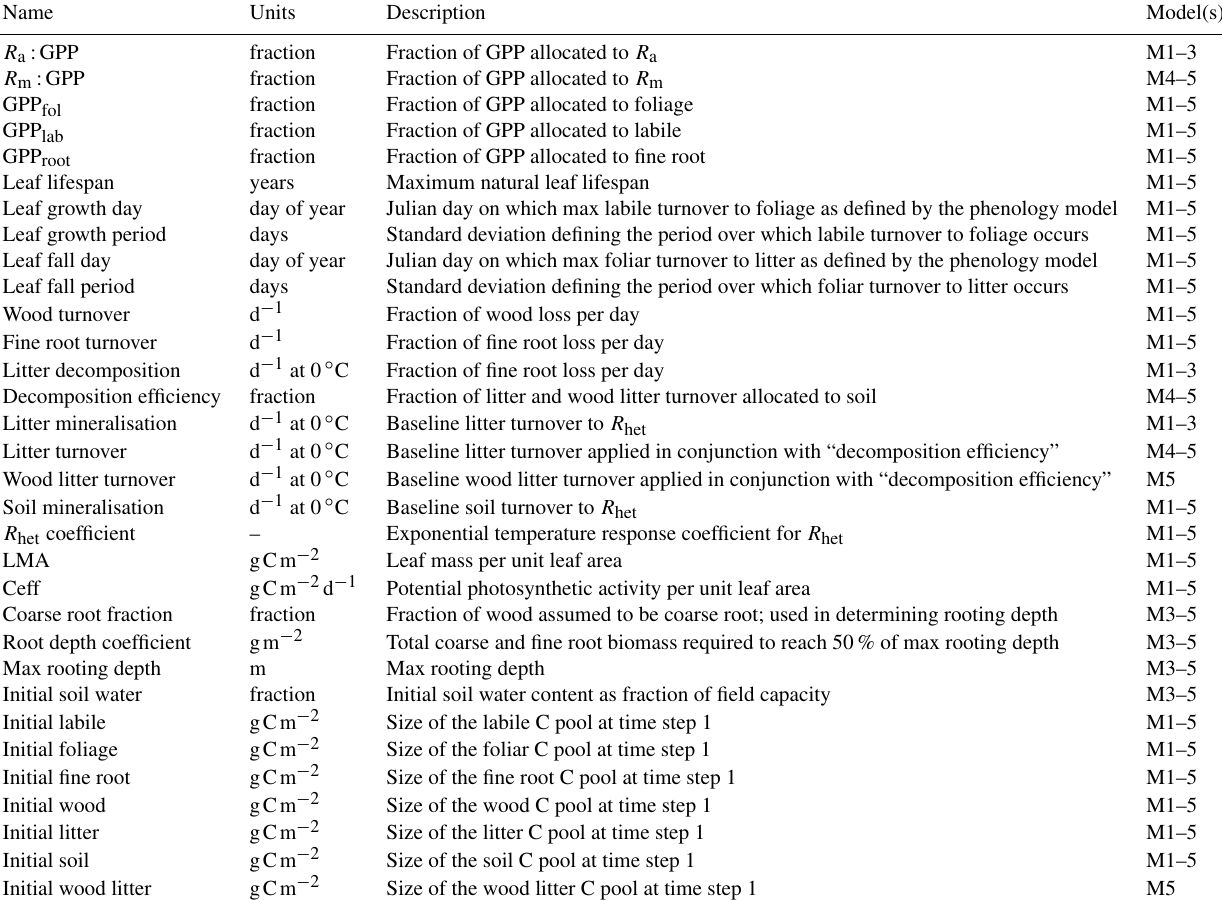
Table A1. Description of parameters estimated for each DALEC model; each parameter is given a name, unit and description. As not all parameters are used by all models, the applicable models are also given following the code used in the main text. Note: gross pri- mary productivity is indicated as GPP, autotrophic respiration is indicated as R a , autotrophic maintenance respiration is indicated as R m , and heterotrophic respiration is indicated as R h . Litter is assumed to be the combined foliage and fine root litter pools, where ap- propriate wood litter will be explicitly stated. Note that GPP allocation fractions are applied sequentially such that GPP allocation